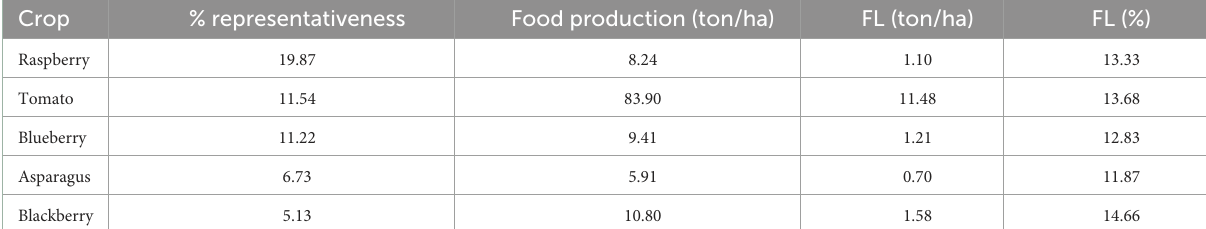
TABLE 4 Average information for the most representative crops.